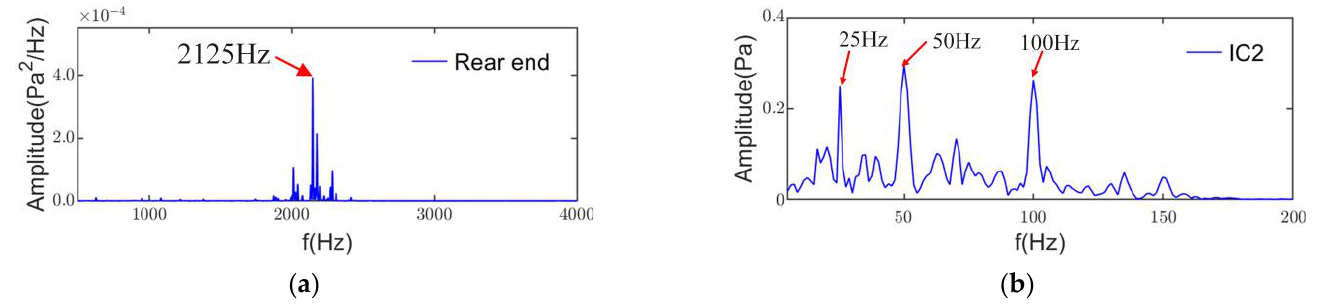
Figure 16. ( a ) PSD of rear end noise signal; ( b ) envelope spectrum of IC2. Among the factors that cause radial electromagnetic force noise in induction motors,